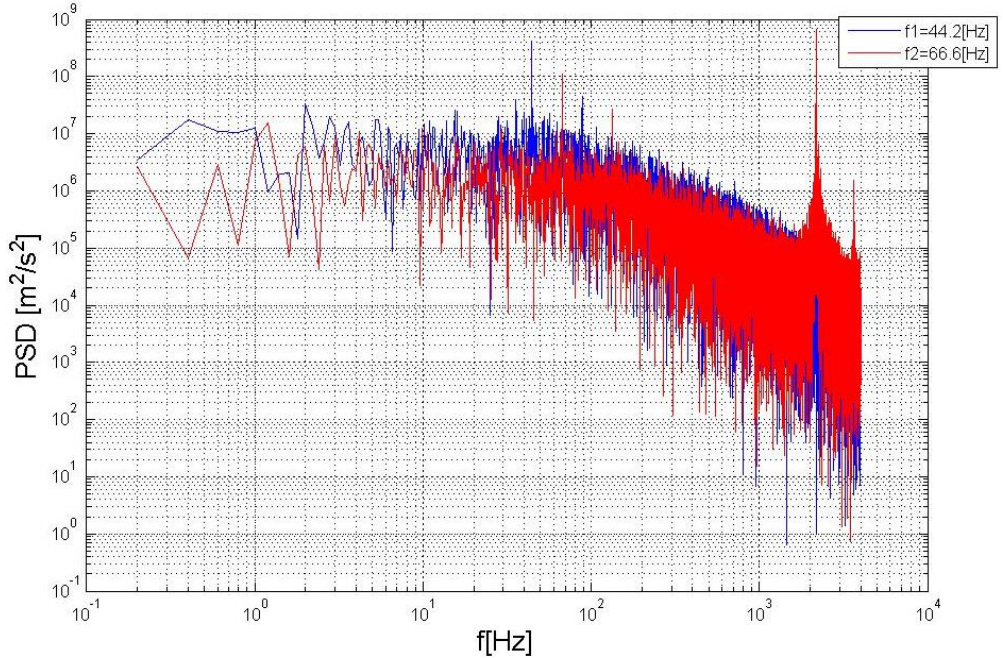
Figure 15. Power spectra showing multiples of actuation frequency at Re = 100,000 and α = 16 ◦